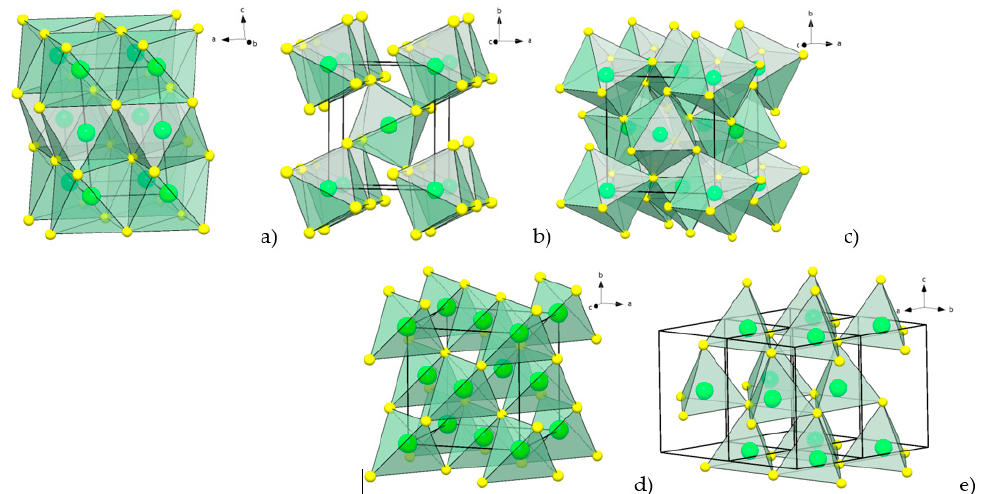
Figure 43. Crystal structures of sulphides: ( a ) pyrrhotite, ( b ) marcasite, löllengite, arsenopyrite, ( c ) pyrite, ( d ) sphalerite, chalcopyrite, ( e ) greenockite, würtzite. Green balls are cations, yellow balls are anions. In the structure of arsenopyrite, half of the anions are S ions, and half are As ions. In the structure of chalcopyrite, half of the cations are Cu ions and half are Fe ions.